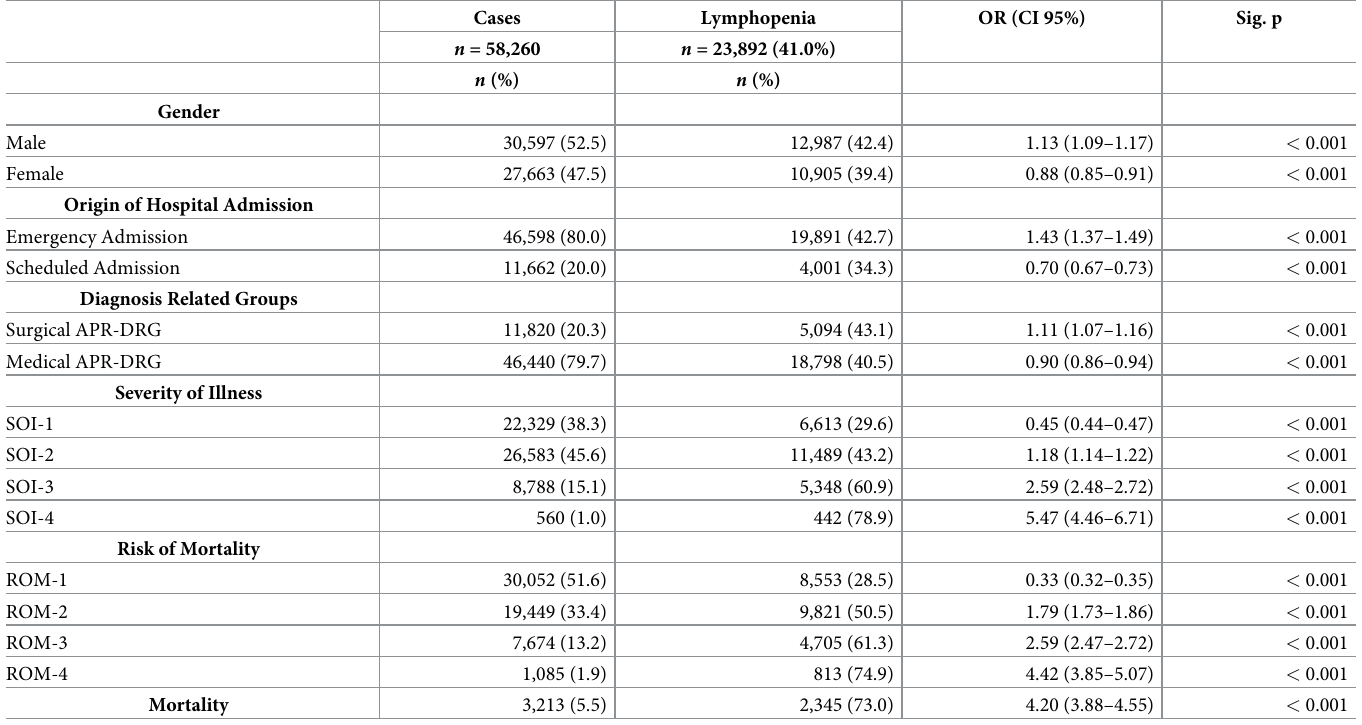
Table 1. Characteristics of admitted patients and their relationship with lymphopenia (univariant